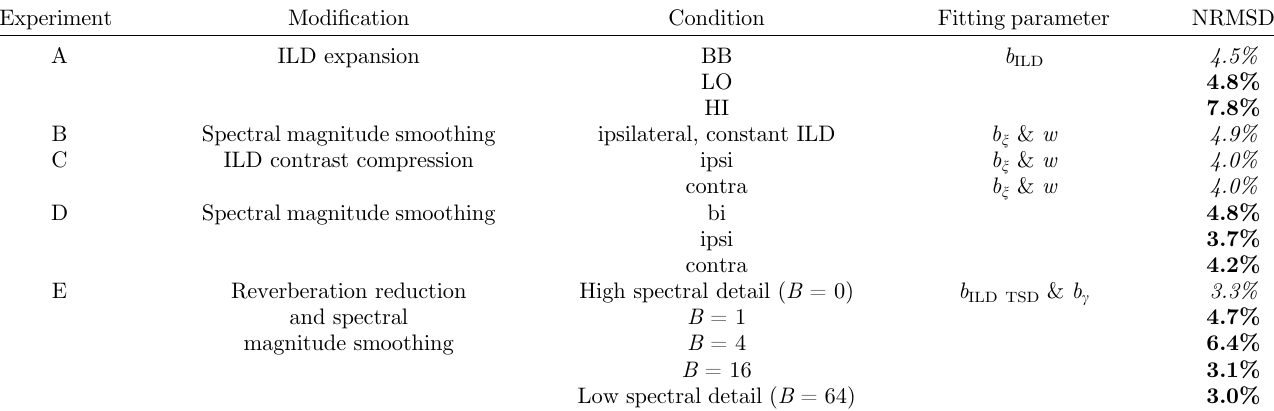
Table 4. Averaged prediction error (NRMSD) between the predicted and perceptual data. The mapping and prediction errors of calculated results are shown in italic and bold,